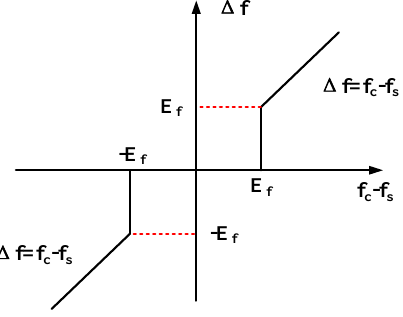
Figure 4. The enhanced frequency dead zone proposed by a previous work.